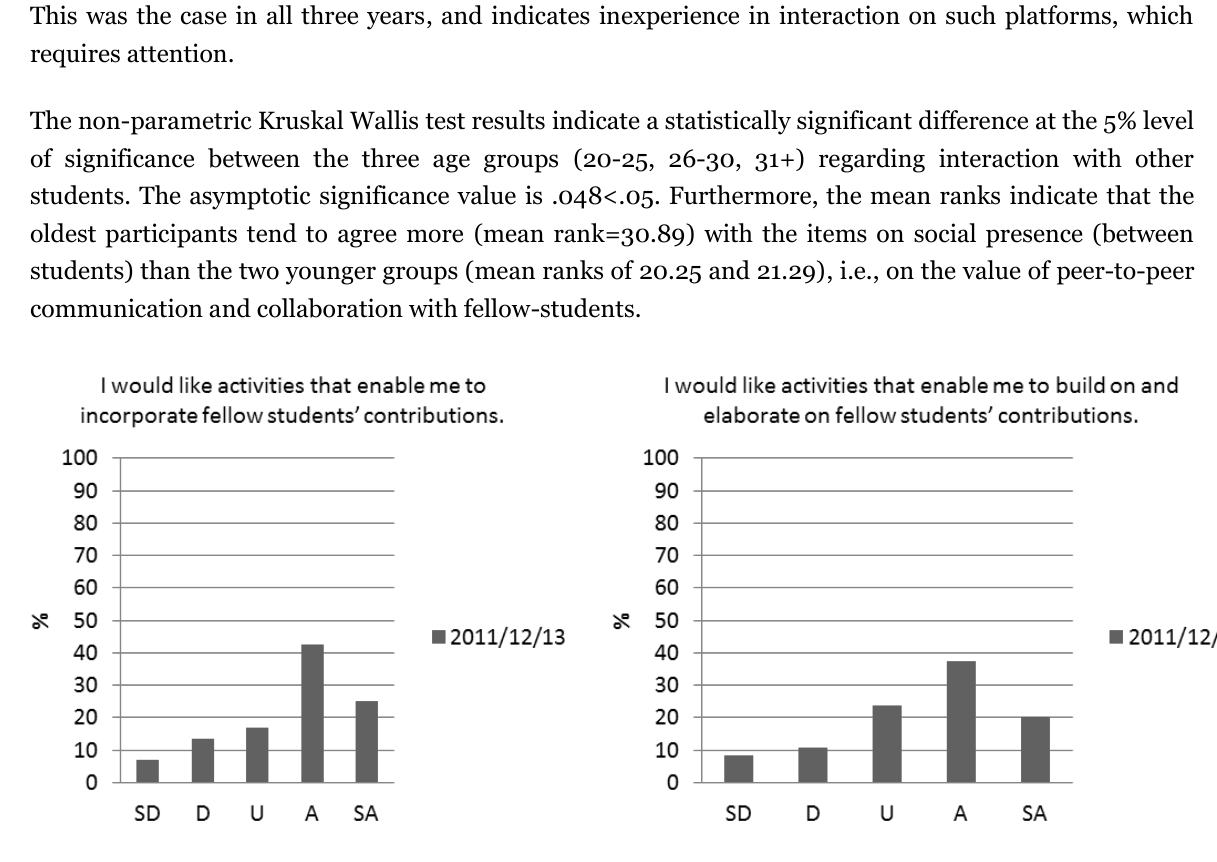
Figure 3 . Responses indicate that students are more keen to incorporate others’ contributions rather than build on them themselves